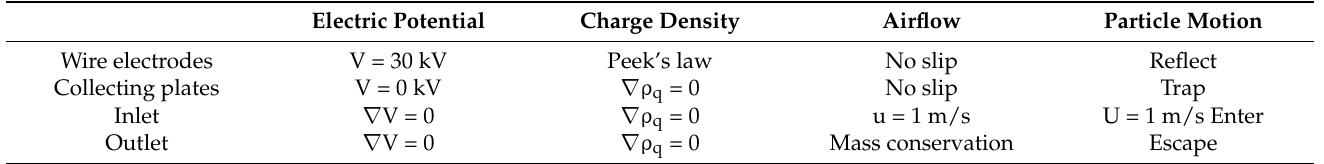
Table 1. Boundary conditions applied to the ESS